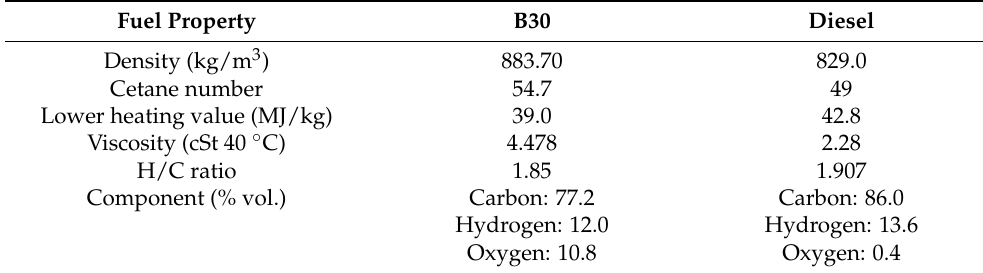
Table 2. Fuel properties